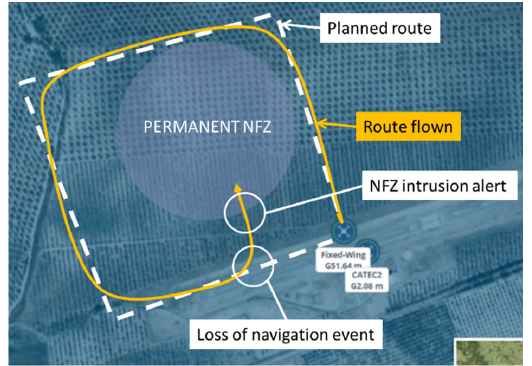
Figure 6. NFZ intrusion scenario with the key elements highlighted.